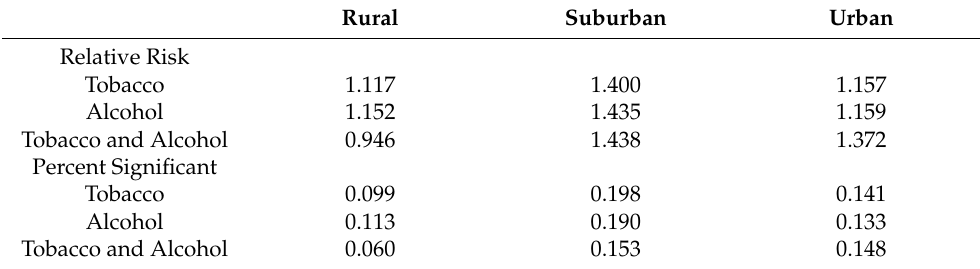
Figure 1. Relative risk for tobacco retail outlet (TRO), alcohol retail outlet (ARO), and tobacco and alcohol retail outlet (TARO) modeled from Bayesian shared component index model. Table 1. Mean relative risks and percent significantly elevated relative risks for outlet types by population density category of block groups.